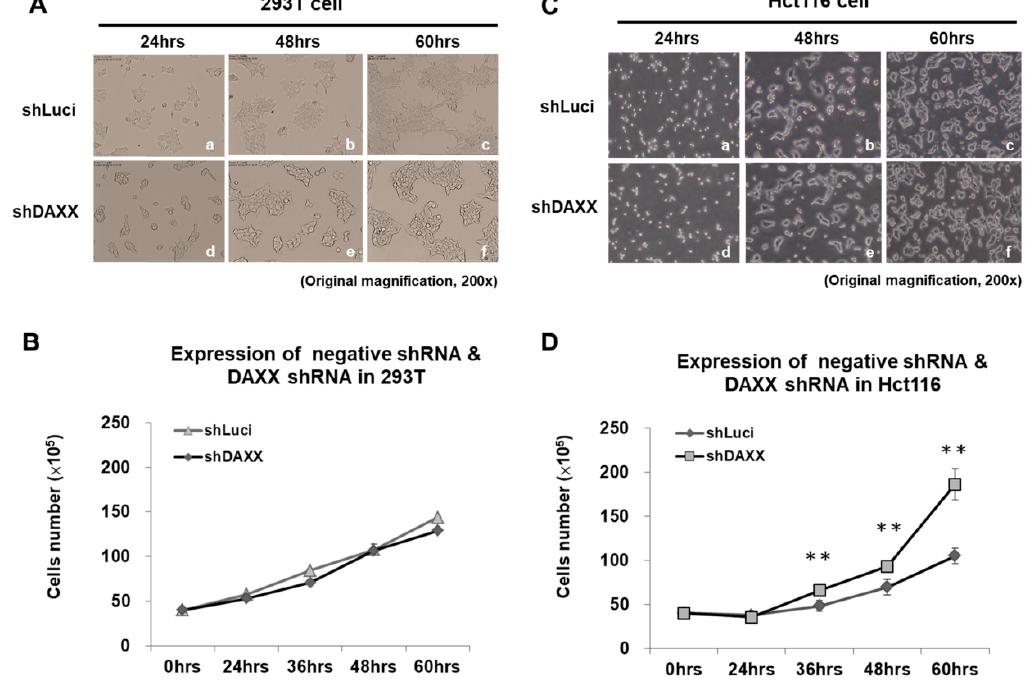
Figure 2. DAXX expression decreased, promoting CRC cell proliferation. We cultured ( A ) 293T (human embryonic kidney) and ( C ) Hct116 (human malignant CRC) cells for 0–60 h. Trypan blue stain assay was used to analyze proliferation rates. ( B , D ) DAXX knockdown promoted Hct116 cells proliferation, but not that of 293T cells. At 36, 48, and 60 h, a significant increase was noted in CRC cells proliferation after DAXX knockdown compared with luciferase-knockdown CRC cells (negative control). ** p < 0.005, Student t test; n.s. = nonsigni fi cant.